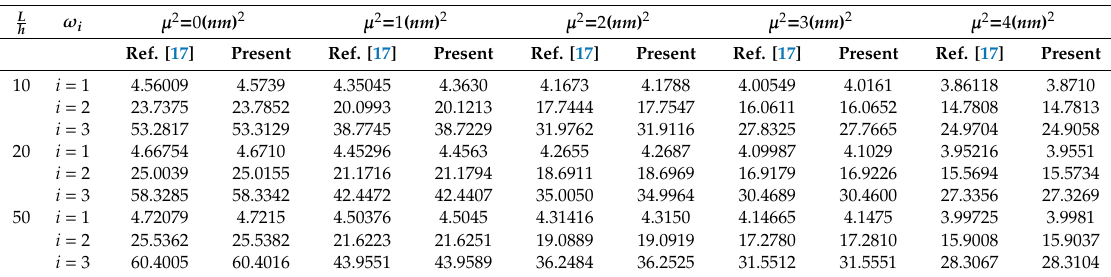
Table 2. Variation of the natural frequency for a S-S curved FG nanobeams and di ff erent aspect ratios, mode numbers, and nonlocal parameters; n = 1 and α = π /2.